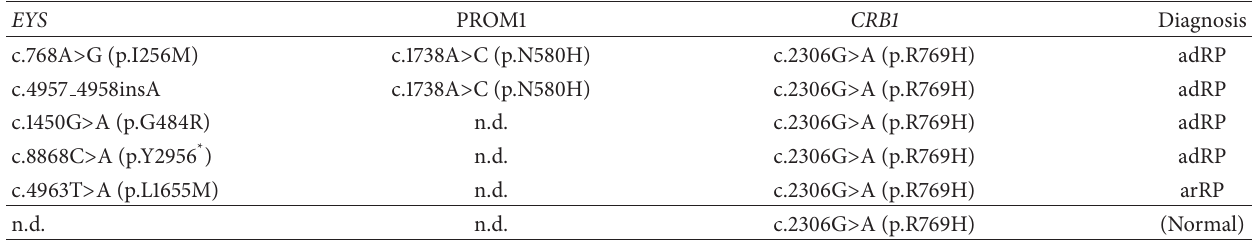
Table 7: Association of EYS , PROM1, and CRB1 in retinal